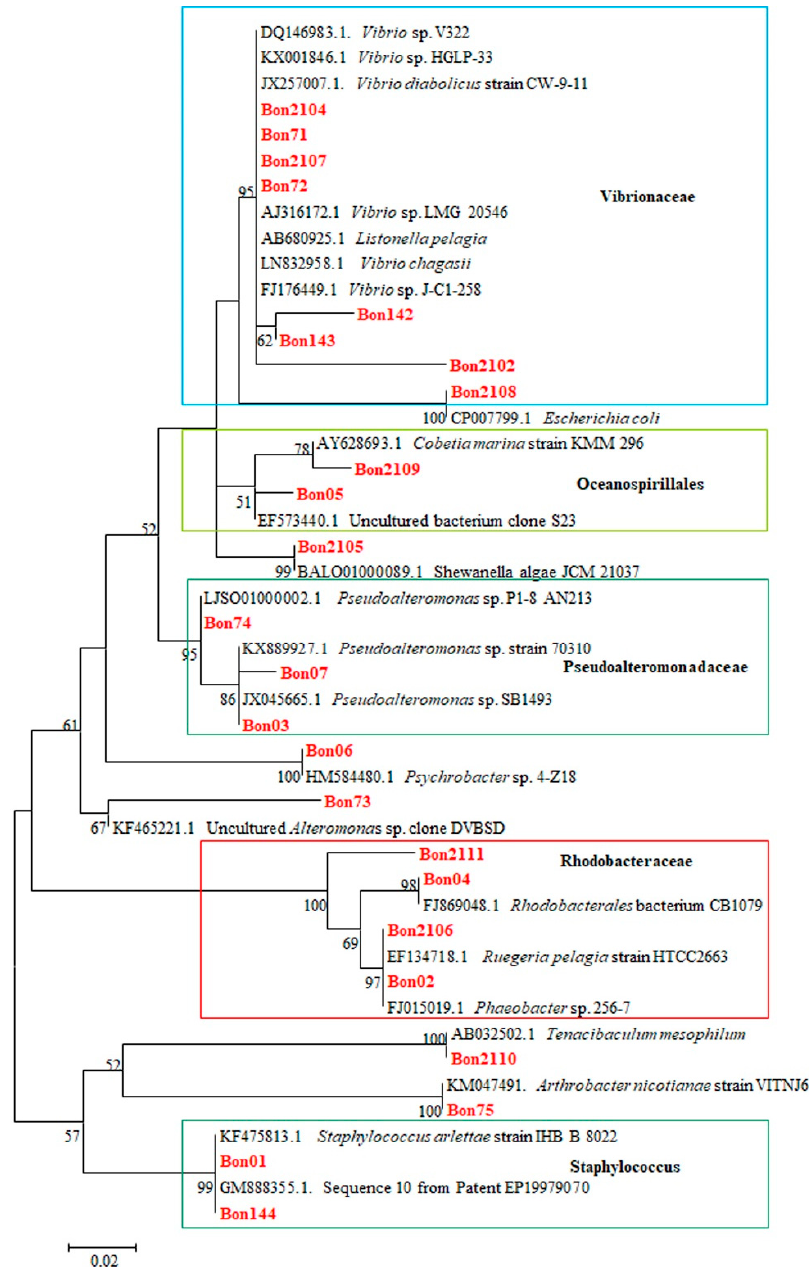
Figure 1. Molecular Phylogenetic analysis by Maximum Likelihood method based on the Tamura-Nei model. The percentage of trees in which the associated taxa clustered together is shown next to the branches. The analysis involved 47 nucleotide sequences. All positions containing gaps and missing data were eliminated. There were a total of 181 positions in the final dataset. Evolutionary analyses were conducted in MEGA7 [2]. In red, samples of the present study are shown. Within the frame in the light blue are representatives of the Vibrionacae, in the light green of the Oceanospirillales, in the olive green of the Pseudoalteromonadaceae, in the red of the Rhodobacteraceae, and in the dark green the representatives of the genus Staphylococcus.